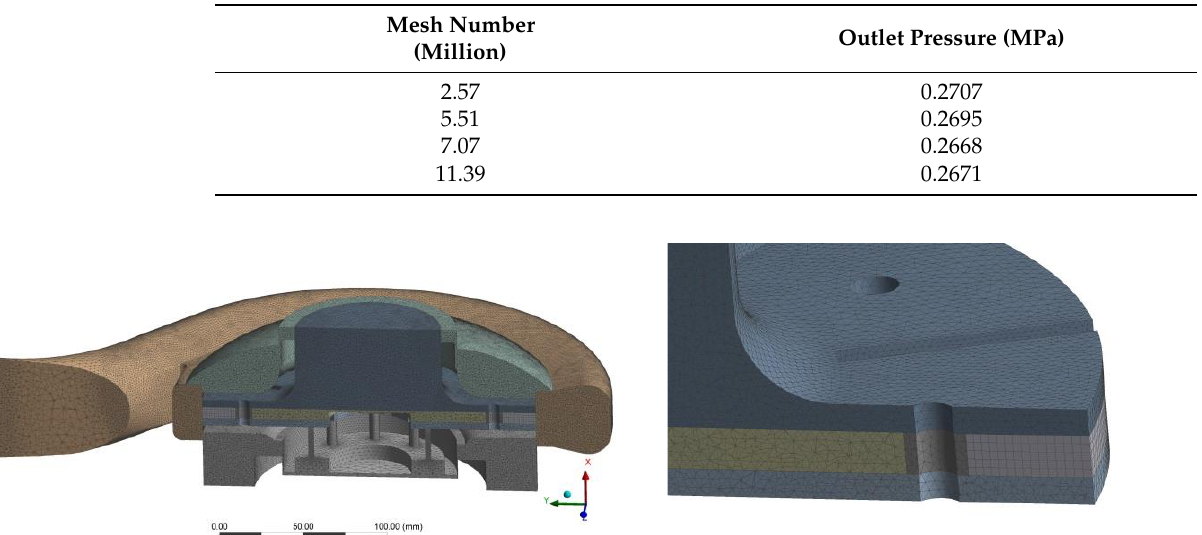
Figure 4. The mesh section of the impeller and casing flow channel and the partial mesh section near the connection column. Table 2. Mesh independence validation.